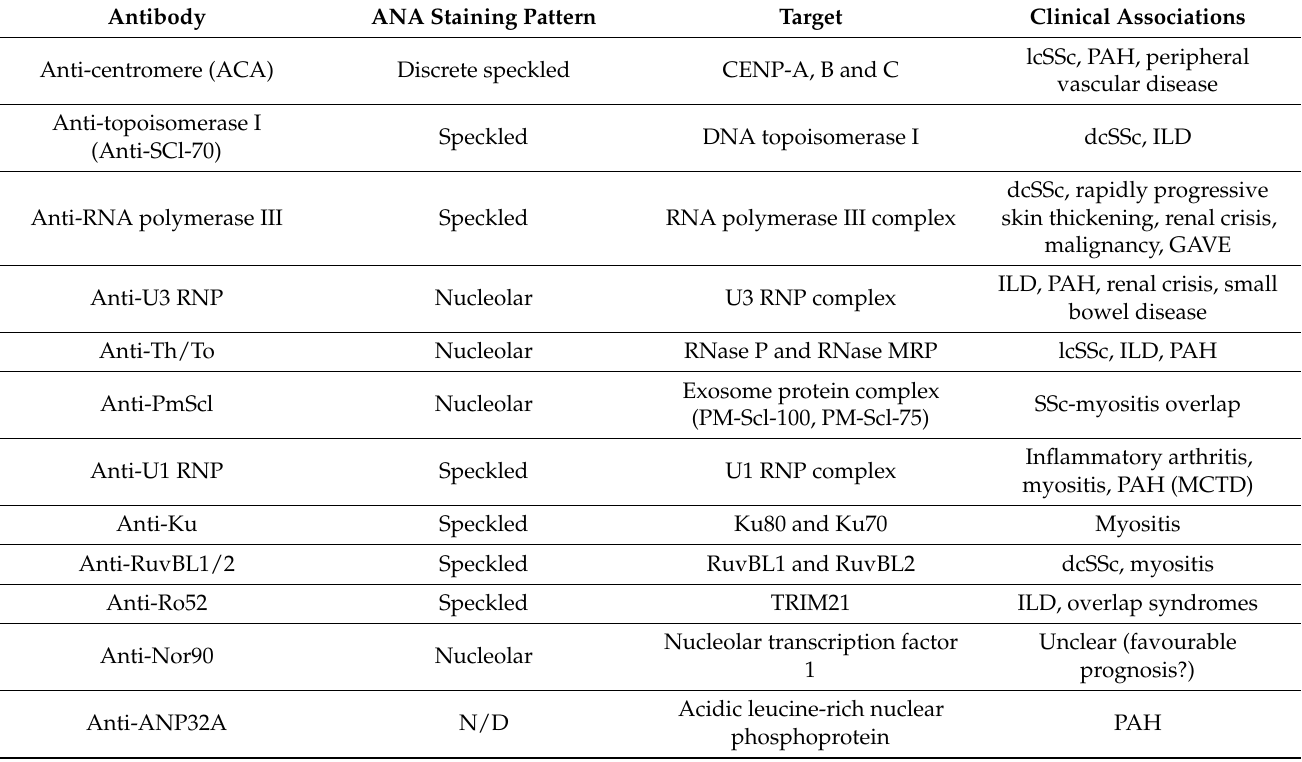
Table 1. Autoantibodies in systemic